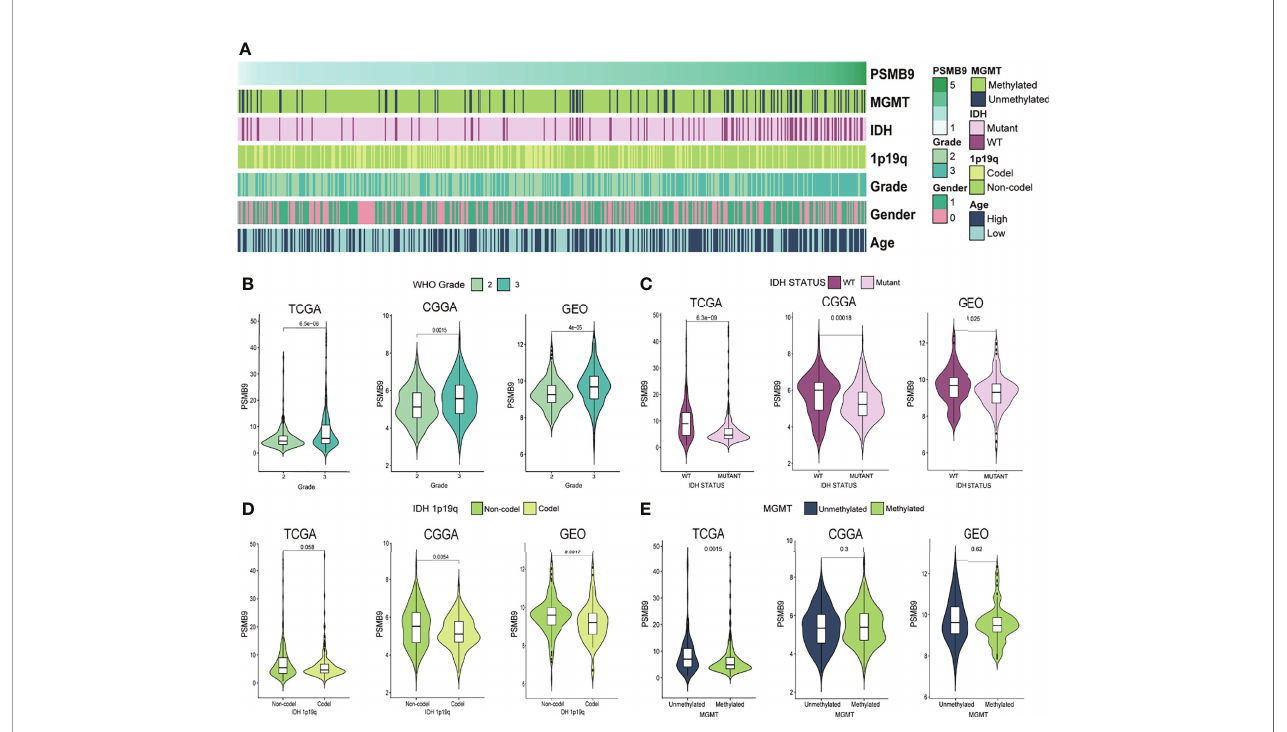
FIGURE 3 | PSMB9 correlated with the clinical and molecular characteristics of gliomas. (A) Heatmap reveals the relationship between various clinical features in each sample of different PSMB9 expressions. (B – E) The violin plot shows the signi fi cant difference in WHO Grade (B) , IDH status (C) , IDH 1p19q (D) and MGMT (E) in different PSMB9 expression